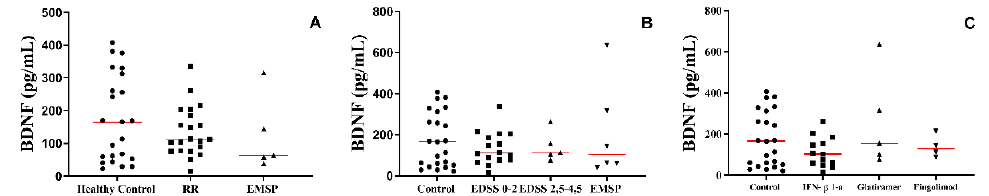
Figure 6. Plasma’s BDNF protein level in different scenarios. ( A ) Between the groups: healthy control, RR group (patients with relapse–remitting multiple sclerosis), EMSP group (patients with secondary progressive multiple sclerosis), and patient control (other neurological diseases). ( B ) Between the groups: healthy control, RR group (patients with relapse–remitting multiple sclerosis) divided according to EDSS scale: 0–2 and 2.5–4.5; EMSP group (patients with secondary progressive multiple sclerosis). ( C ) Between the groups: healthy control and RR group divided according to the treatment: IFN- β 1-a = interferon B 1-a, glatiramer acetate, and fingolimod. Rows represent the median. We used the Kruskal–Wallis test with Dunn’s post-test.